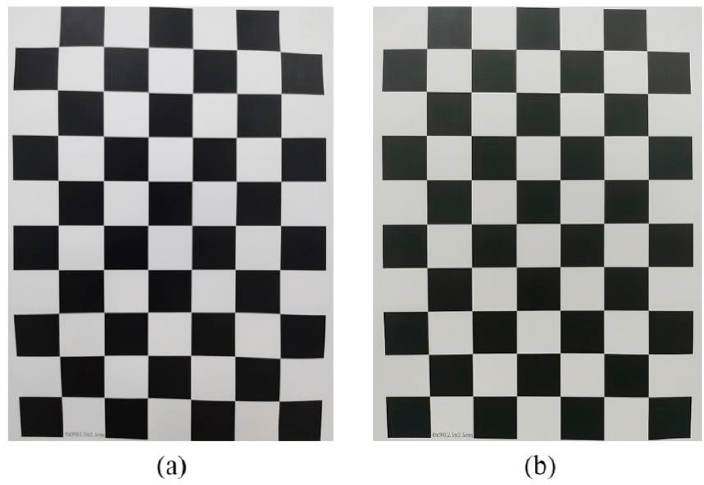
Figure 5. Smartphone image correction: ( a ) Before correction; ( b ) After correction.